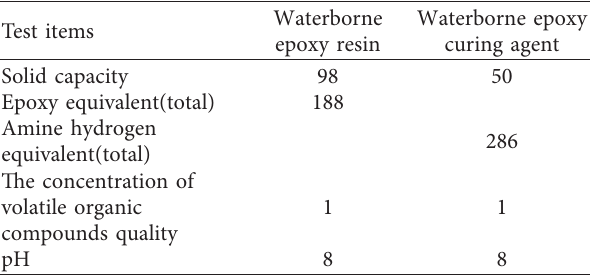
Table 3: Test results of water-based epoxy resin and waterborne epoxy curing